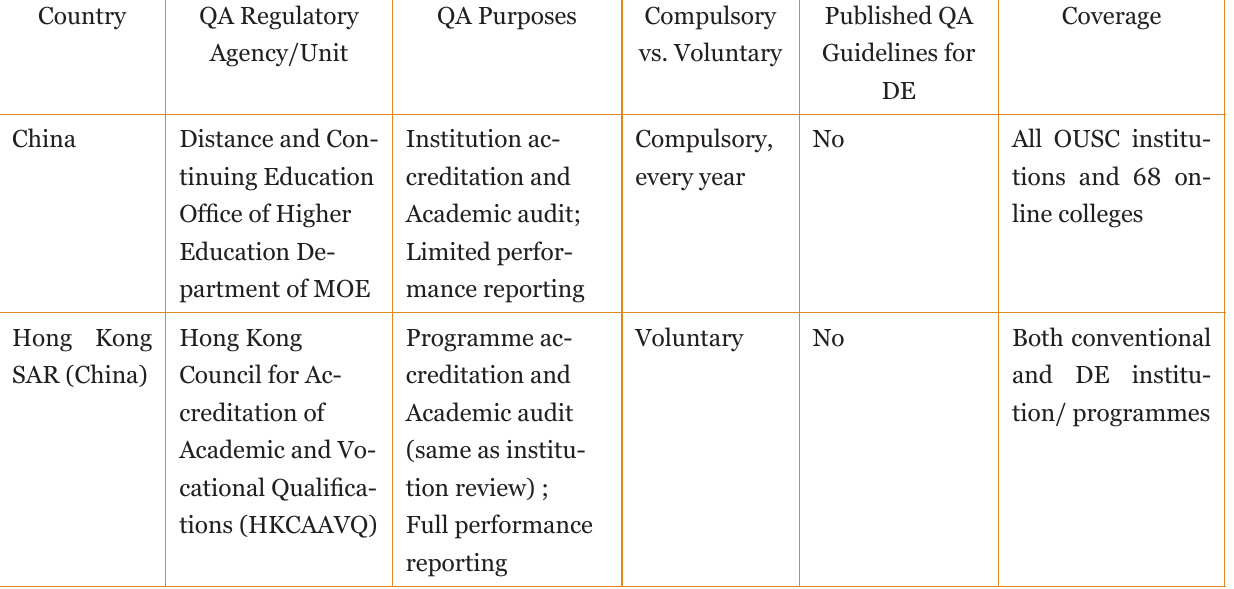
Features of QA Regulatory Accreditation Agencies in 11 Asian Countries/Territories